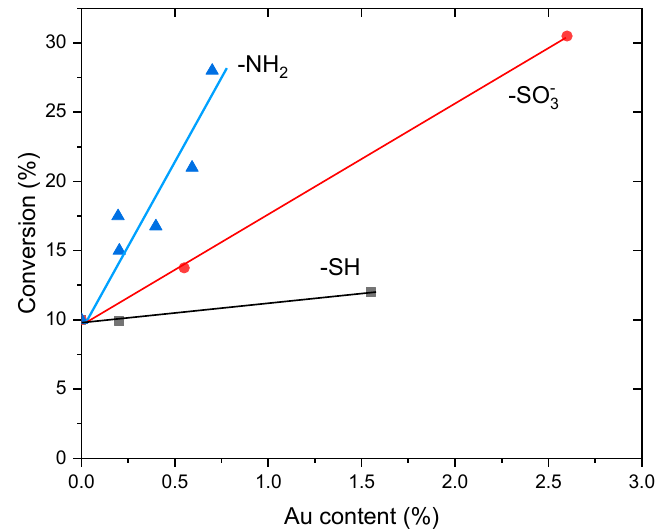
Figure 8. Conversion (t = 24 h) vs. Au content for catalysts supported on SBA-15 silica containing anchored − NH 2 (from this work), -SO 3 − and − SH groups (taken from ref. [14]).